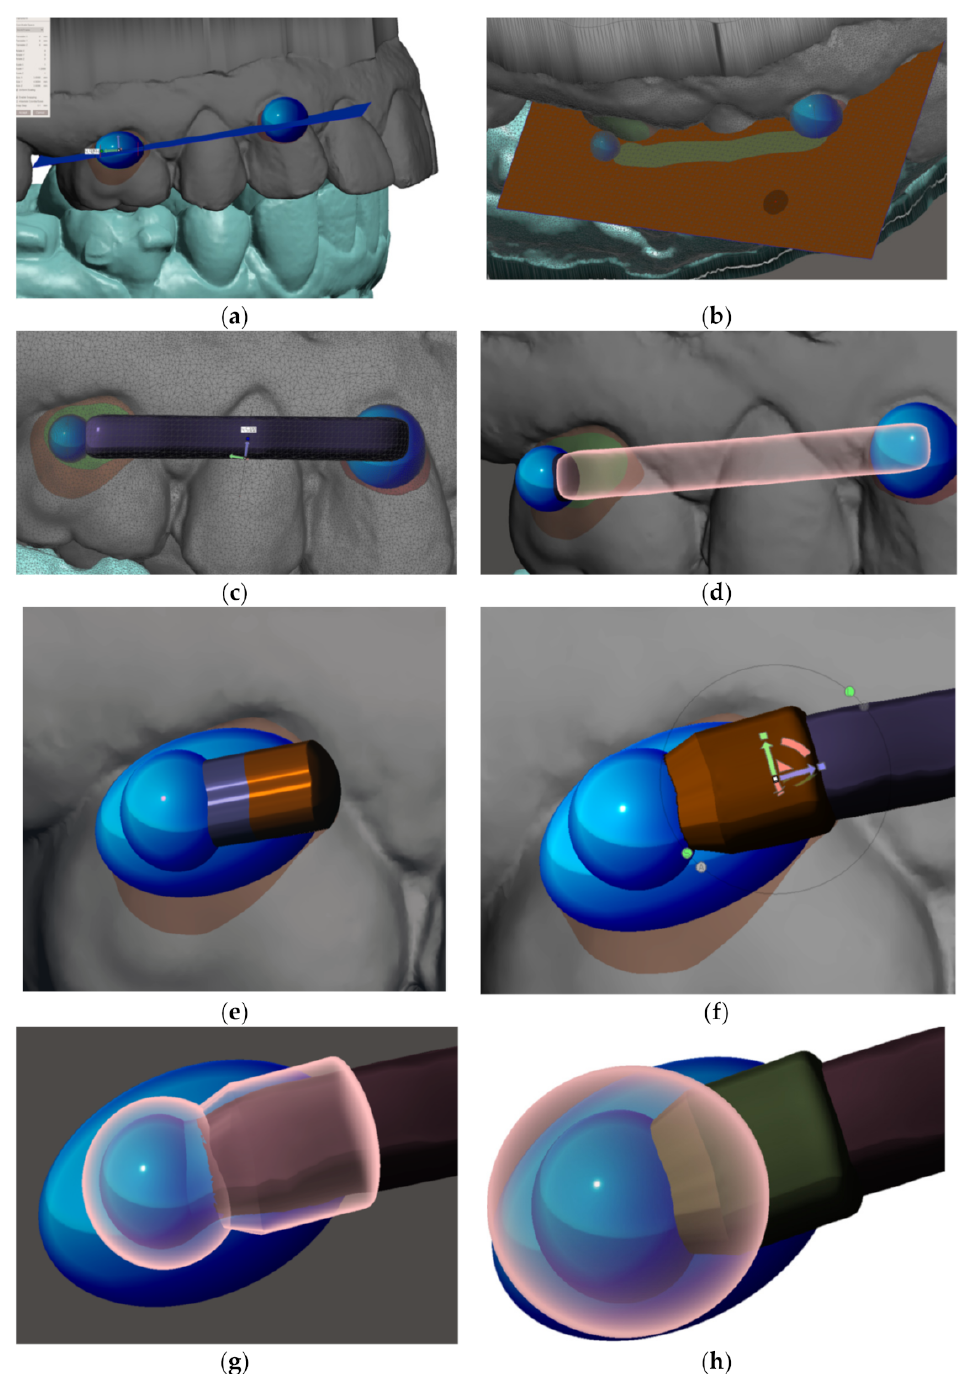
Figure 7. Method of designing personalized distalizer. ( a ) placing a plane for the upper border of arm of the distalizer and spheres overlaying teeth surfaces in the areas of future individualized adhesion pads; ( b ) optimized border and deleting the rest of the plane; ( c ) 4.5 mm extrusion of the 2D plane selection creates the arm of distalizer; ( d ) new sphere (d = 5 mm) on the distal end of the arm represents the terminal joint of the distalizer’s arm. New sphere, with the same centre is created with 0.1 mm bigger diameter and represents the future socket for the joint; ( e ) extrusion of the spherical socket for the joint in the direction of the arm, liberating its movement during distorotation of the molar; ( f ) extending the hiatus of the distalizer’s arm access to the joint socket; ( g ) visualization of the future joint socket and its access together with a distalizer’s arm distal ending with a spherical joint; ( h ) creation of final coverage of the joint with a new sphere resized as necessary to cover the joint socket at least by 0.6